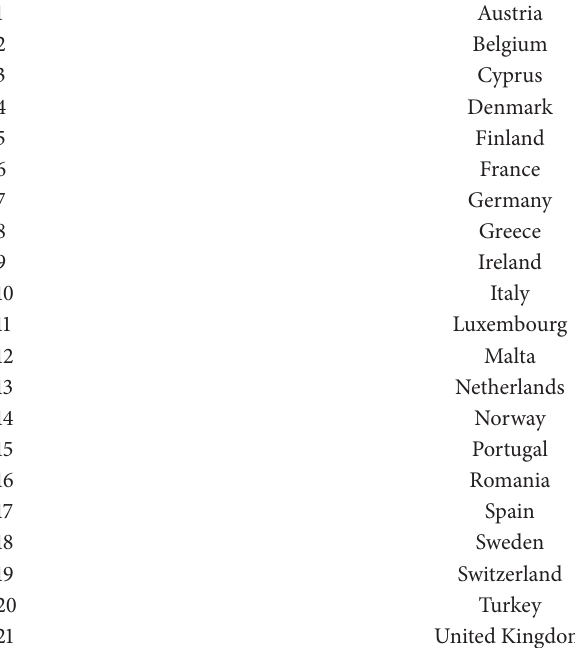
Table 3: Countries considered in the European region.